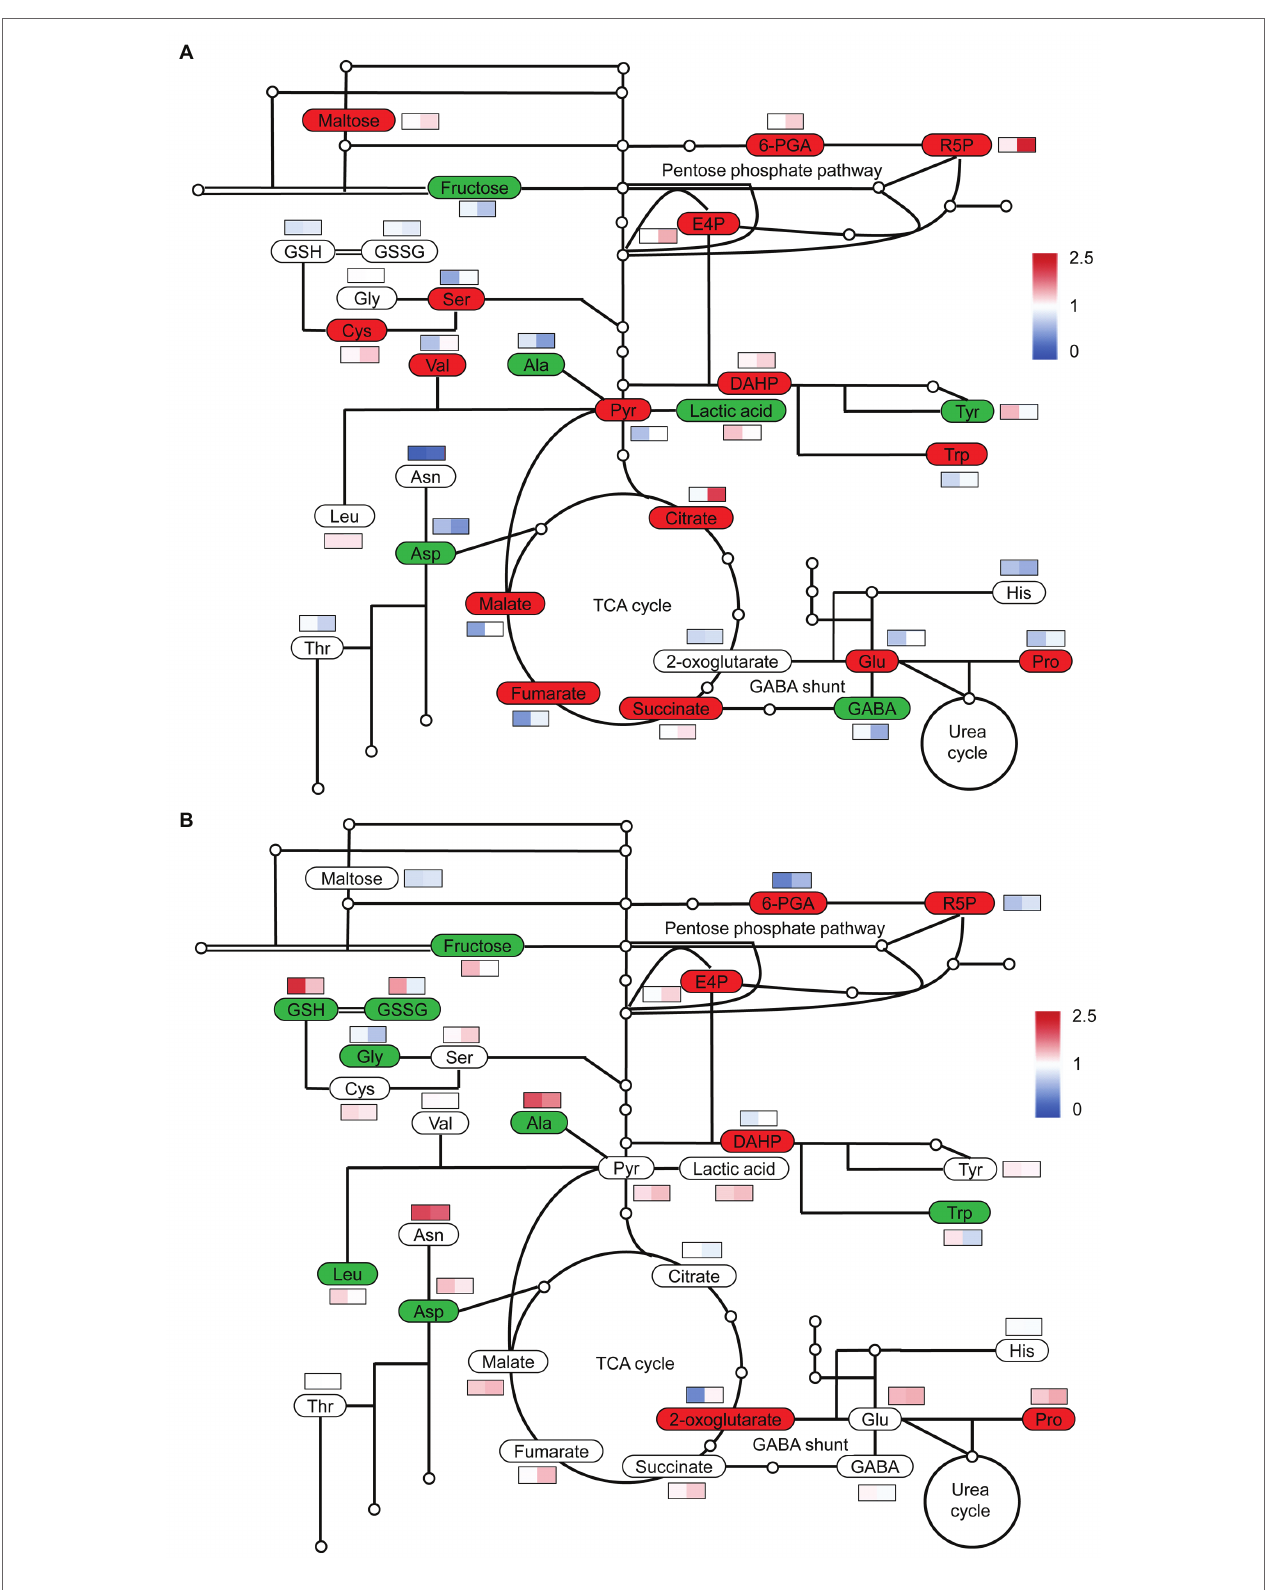
FIGURE 4 | Simplified diagram of changes in carbon and nitrogen metabolites in leaves of A. paniculata plants grown under different nitrogen and sulfur conditions. (A) Changes in metabolites in high S compared with low S under low N conditions. (B) Changes in metabolites in high S compared with low S under high N